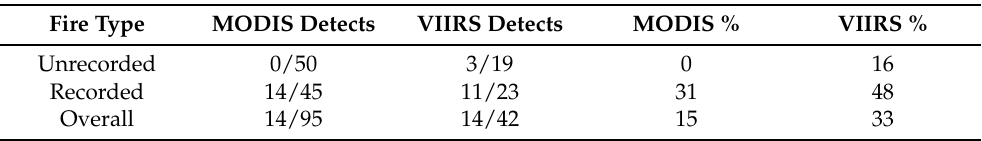
Table 2. Thermal anomaly detection rates in the Brooks Range Foothills ecoregion by MODIS